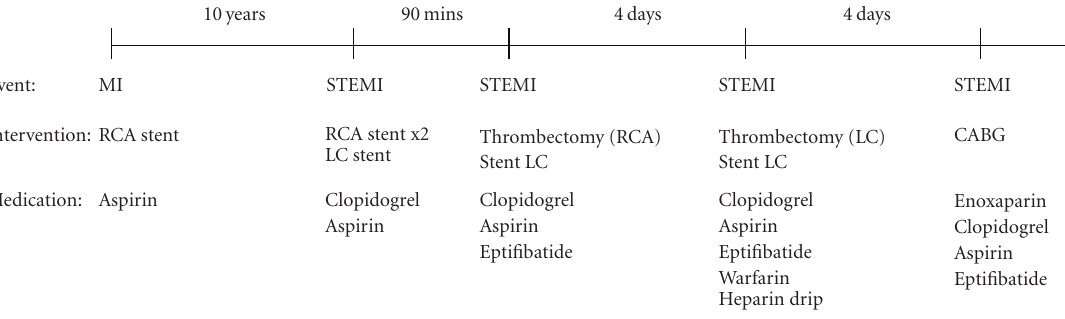
Figure 3: Timeline of events, interventions, and